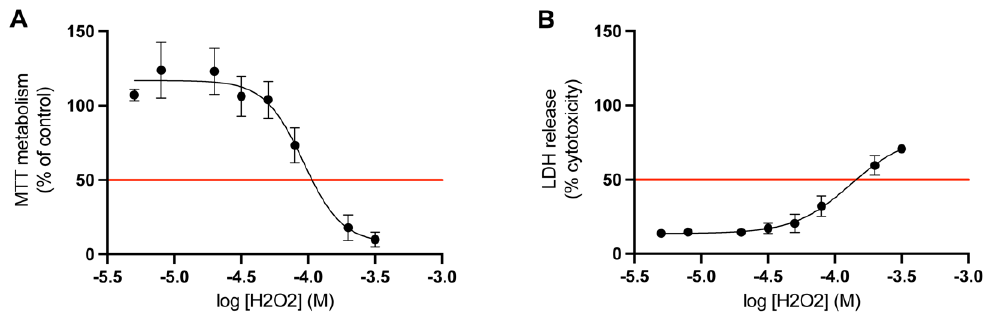
Figure 4. Determination of LD 50 for hydrogen peroxide. The results of the dose response study on primary cortical cells. The red line marks the LD 50 value of hydrogen peroxide (H 2 O 2 ) for ( A ) MTT metabolism and ( B ) LDH release, which was 0.9 × 10 − 4 M and 1.3 × 10 − 4 M, respectively ( n = 3). All data are presented as means ± SEM.